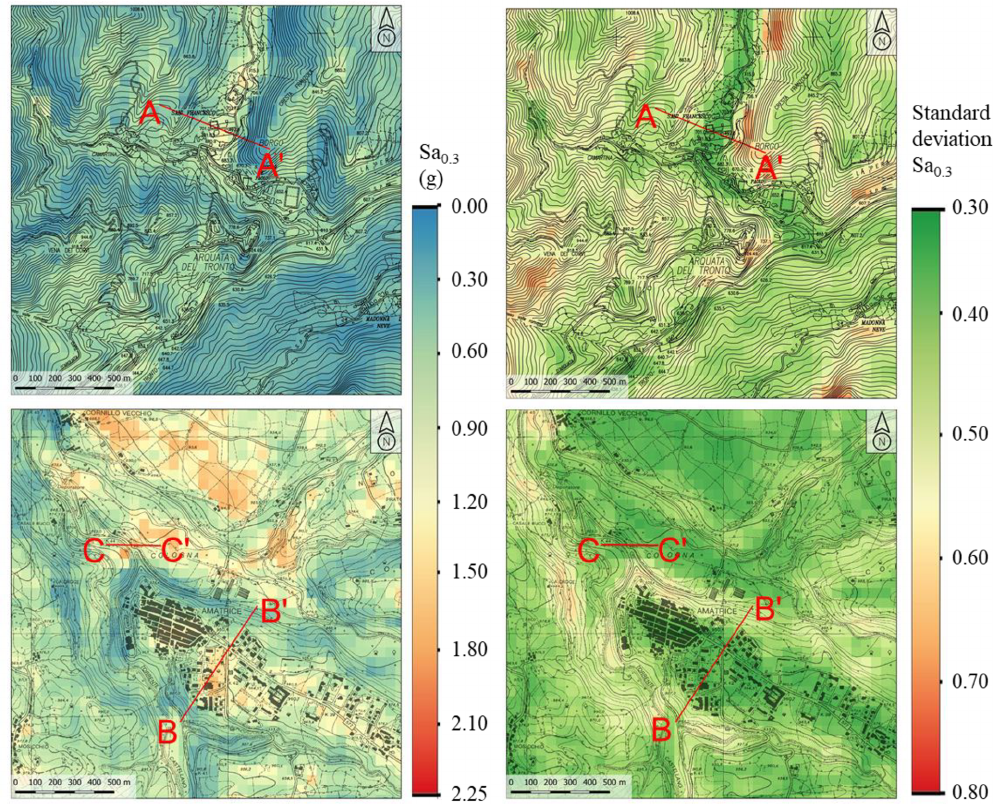
Figure 9. Ground motion prediction maps (central Italy earthquake that occurred on 24 August 2016) regarding Arquata del Tronto (top) and Amatrice (bottom) in terms of the Sa 0 . 3 mean value (left) and standard deviation (right) (resolution of 50m × 50m). The base topographic layer was retrieved from Regione Marche (2021) and Regione Lazio (2021) for Arquata del Tronto and Amatrice. The uncertainty estimation is available at https://it.mathworks.com/help/stats/gaussian-process-regression-models.html(last access: 1 September